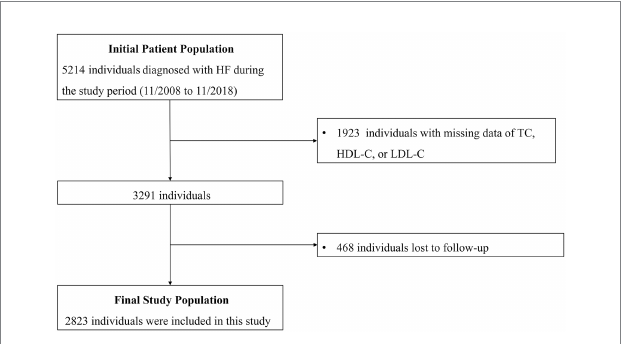
FIGURE 1 Flow diagram of the screening and enrollment of study participants. HF, heart failure; TC, total cholesterol; HDL-C, high density lipoprotein cholesterol; LDL, low density lipoprotein